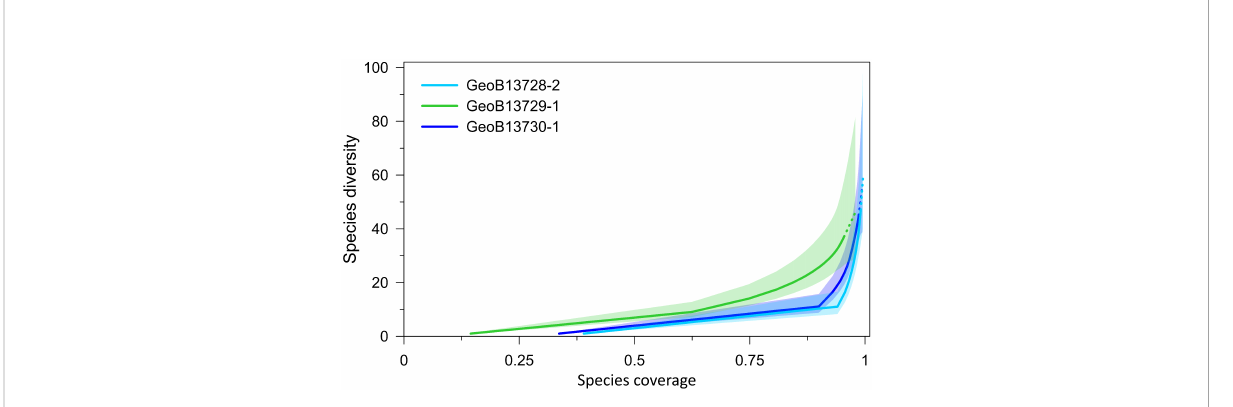
FIGURE 3 Coverage-based species rarefaction curves for each core. Solid lines represent observed data. Dashed lines represent extrapolated trends. Shading corresponds to 95% con fi dence intervals (Hsieh et al.,